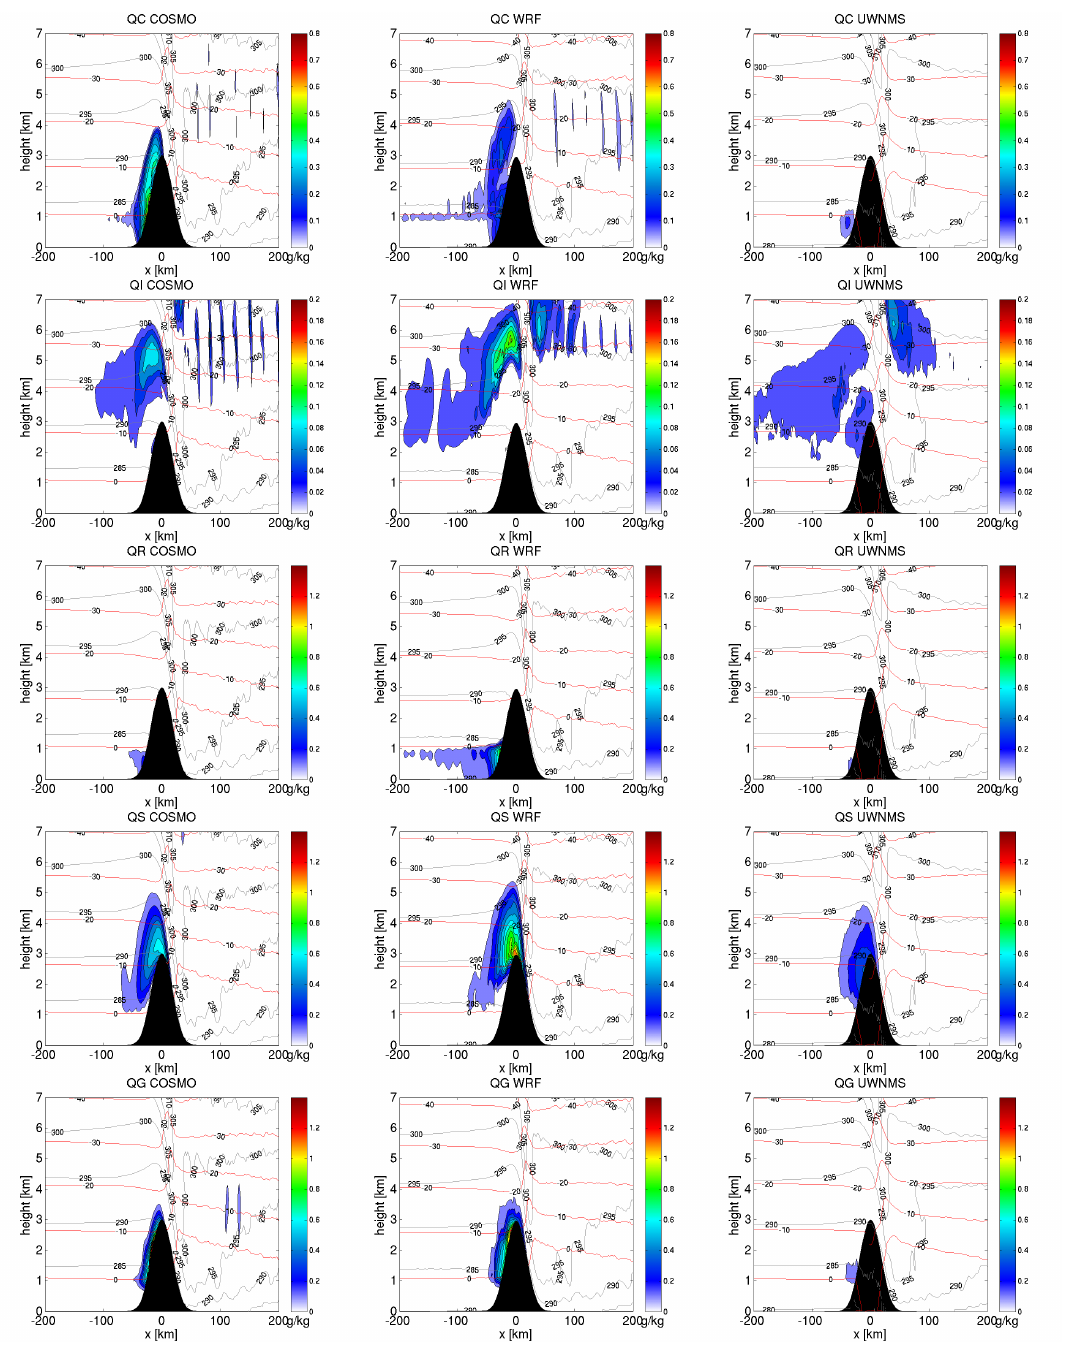
Fig. 15. Same as Fig. 5 but for simulation SIM 3